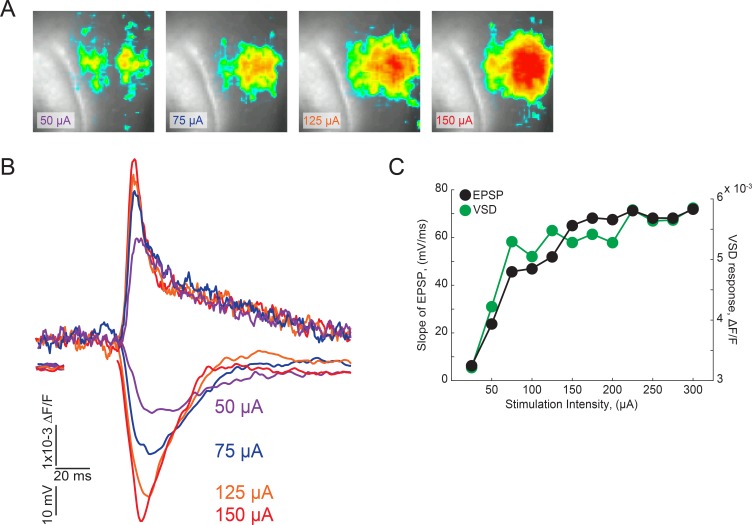
Input-output curves of VSD signal amplitudes and initial slope of fEPSP.(A) Representative images of VSD signals at different stimulus intensities from a representative experiment. (B) Representative traces of dF/F VSD signals and fEPSPs evoked by different stimulus intensities. (C) Input/output relationships of the initial slope of fEPSPs and VSD signals from a representative experiment.